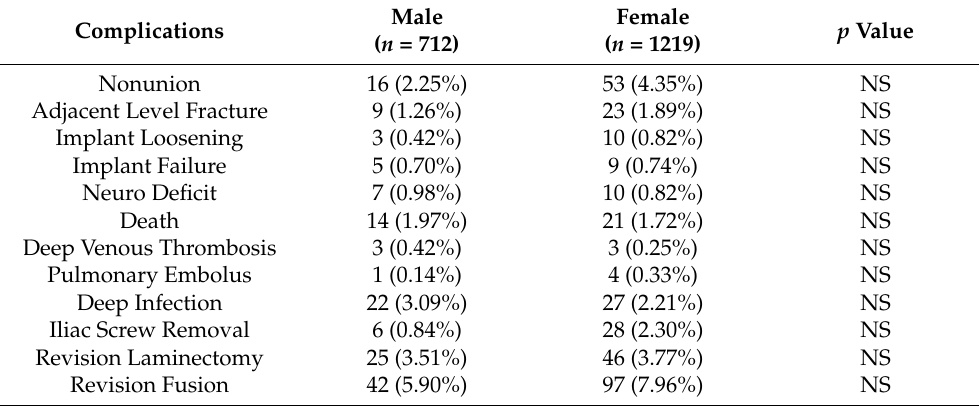
Table 5. Complications separated by